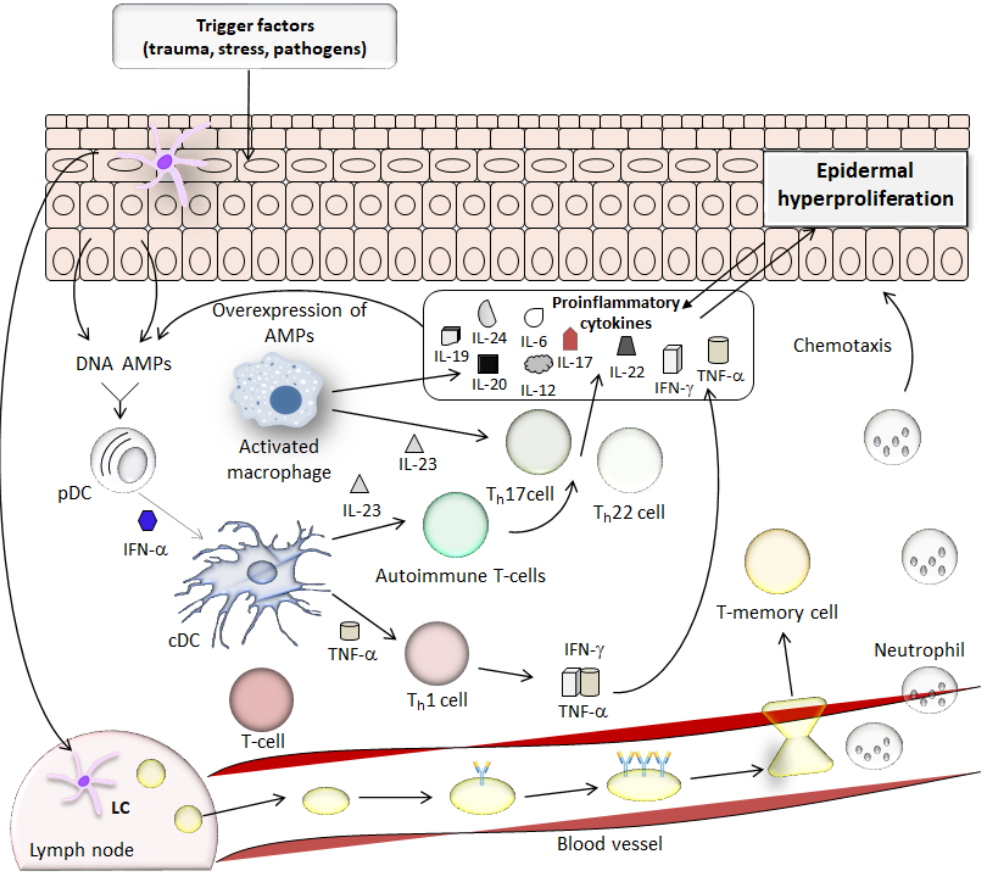
Figure 2. Schematic representation of psoriasis pathogenesis. AMPs—antimicrobial peptides and proteins, pDC—plasmacytoid dendritic cell, cDC—conventional dendritic cell, Th cell—T helper cell, IL—interleukin, TNF—tumor necrosis factor, IFN—interferon, LC—Langerhans cell.